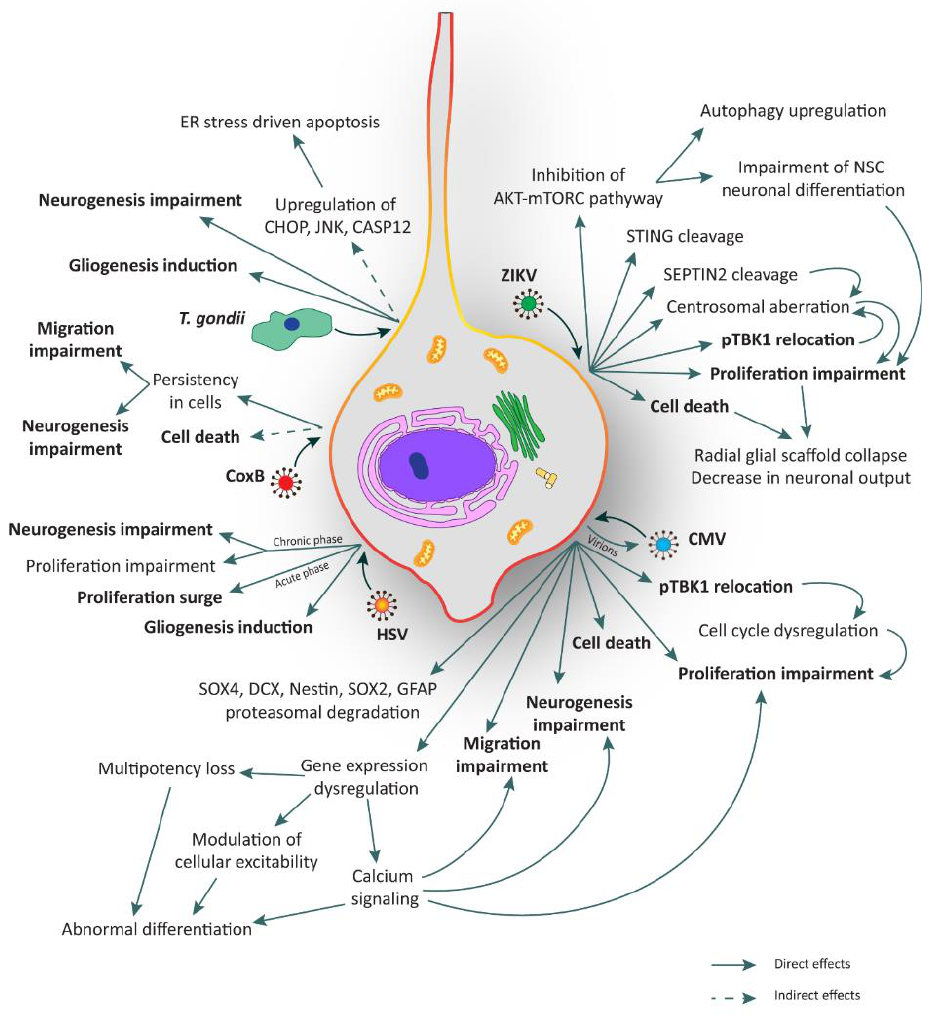
Figure 2. Illustration of the major consequences elicited by TORCH infection in human neural stem cells (hNSCs). hNSCs can be infected by several TORCH pathogens such as Zika virus (ZIKV), Cytomegalovirus (CMV), Coxsackie B virus (CoxB), Toxoplasma gondii ( T. gondii ), and Herpes simplex virus (HSV). All these agents can lead to several and critical consequences such as cell death, proliferation impairment, unbalance of neurogenesis and gliogenesis, and migration impairment. Processes in bold are shared among TORCH pathogens. ER: endoplasmic reticulum.